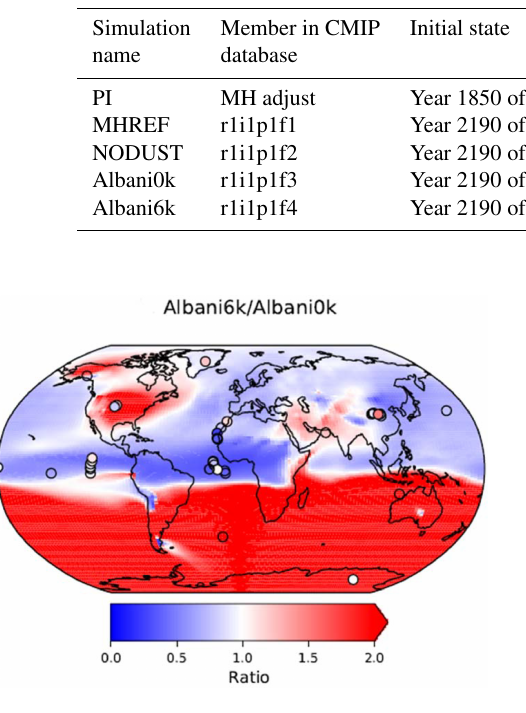
Figure 2. Ratio between Albani et al. (2015) mid-Holocene and pre-industrial dust loads (colour map) and ratio of dust deposition as estimated from dust reconstruction (coloured